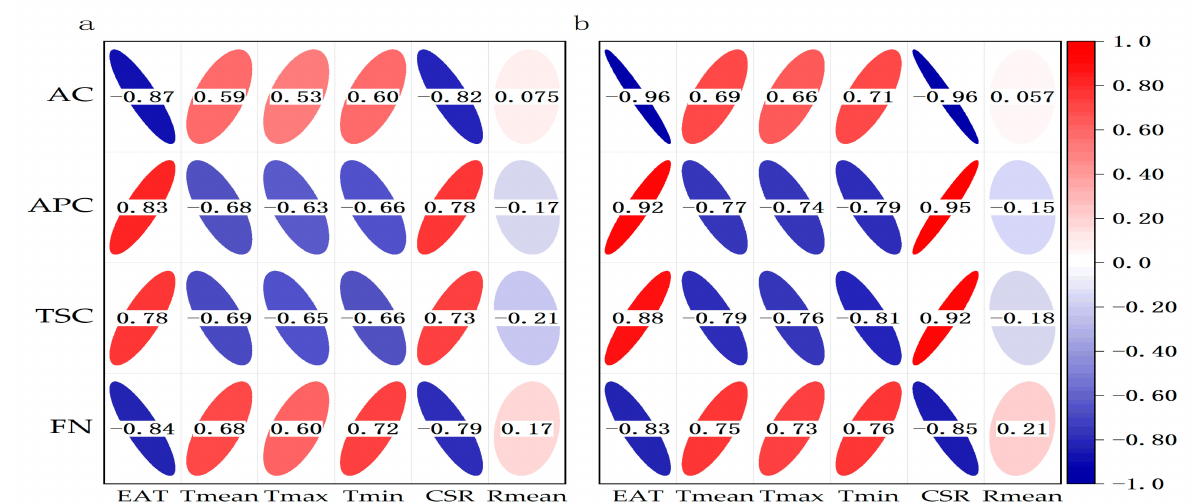
Figure 10. Correlation of different post-anthesis temperatures and radiation on starch and